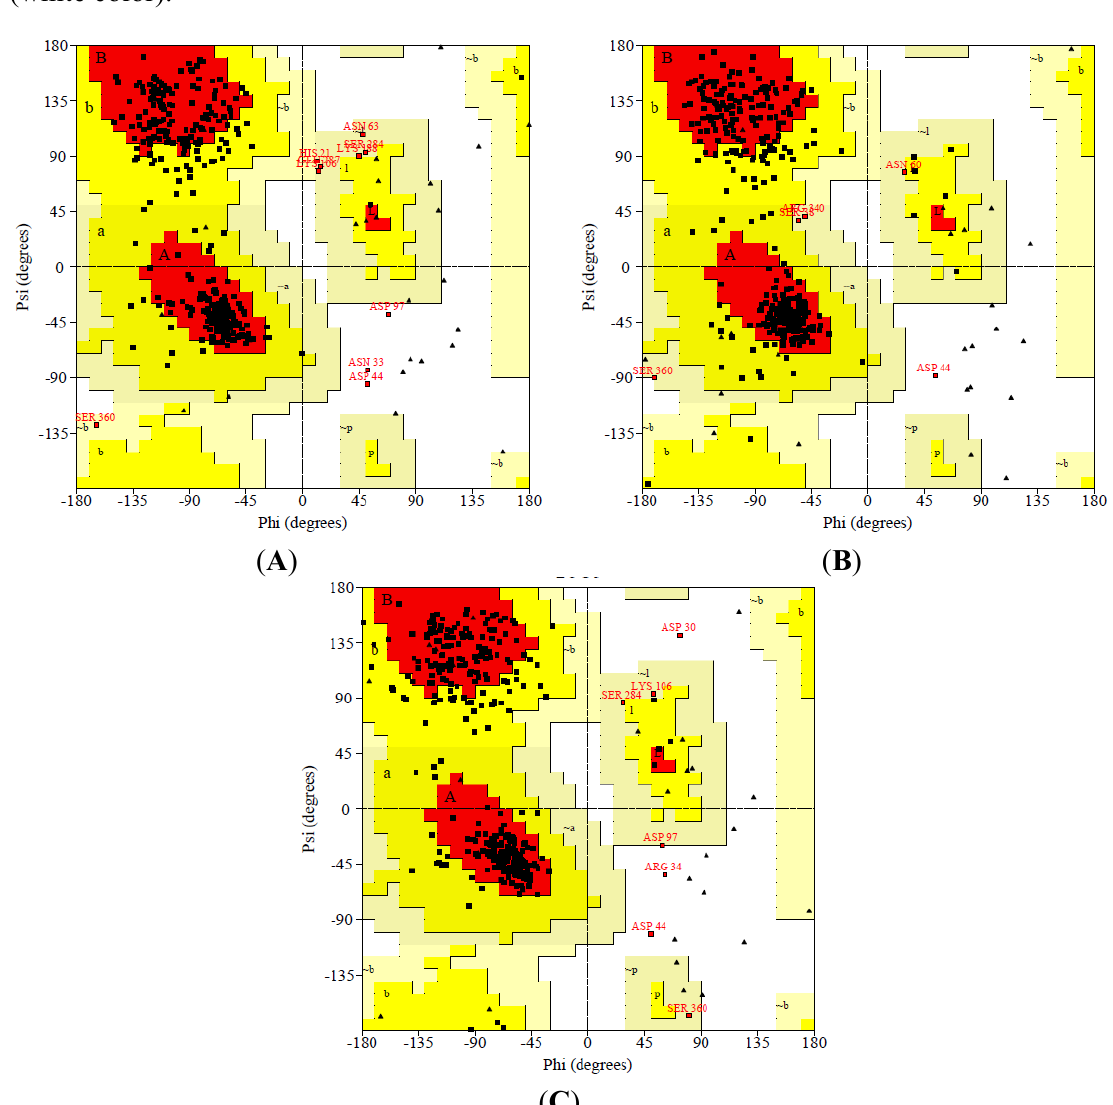
Figure 2. Ramachandran plots generated via PROCHECK for ( A ) NBD protein; ( B ) K71L and ( C ) T204V mutants. PROCHECK shows that the residues in most favored (red), additionally allowed (yellow), generously allowed (pale yellow) and disallowed regions (white